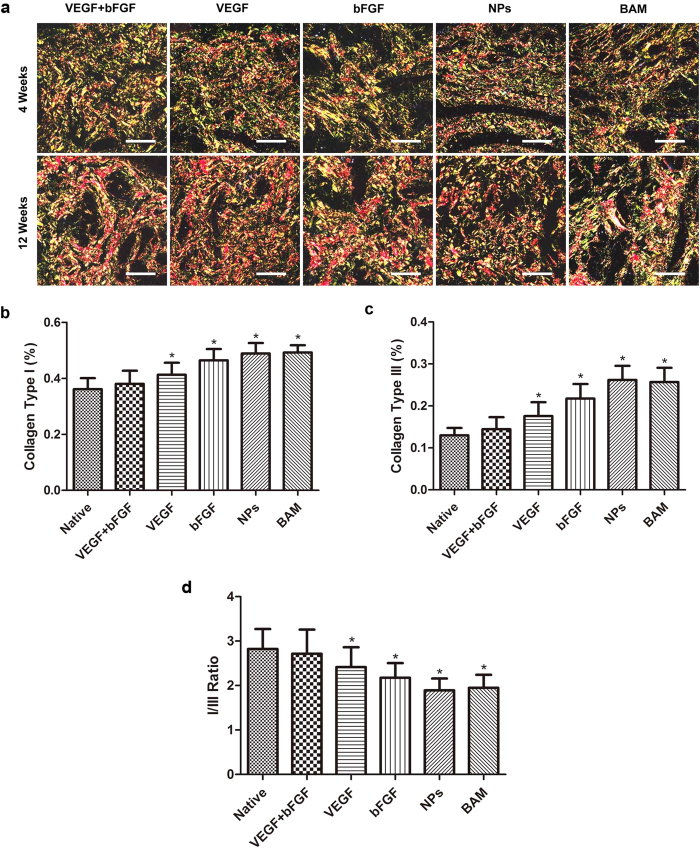
Picric acid-Sirius red staining to assess collagen deposition and degradation.(a) Micrographs of collagen protein expression as indicated by picric acid-Sirius red staining. Scale bars in all panels = 100 μm. Analysis of collagen deposition and degradation: (b) collagen type I, (c) collagen type III, and (d) the ratio of collagen type 1 to collagen type III. The data are expressed as the mean ± SD, and the error bars represent the SD. *p < 0.05 in comparison to the native group.